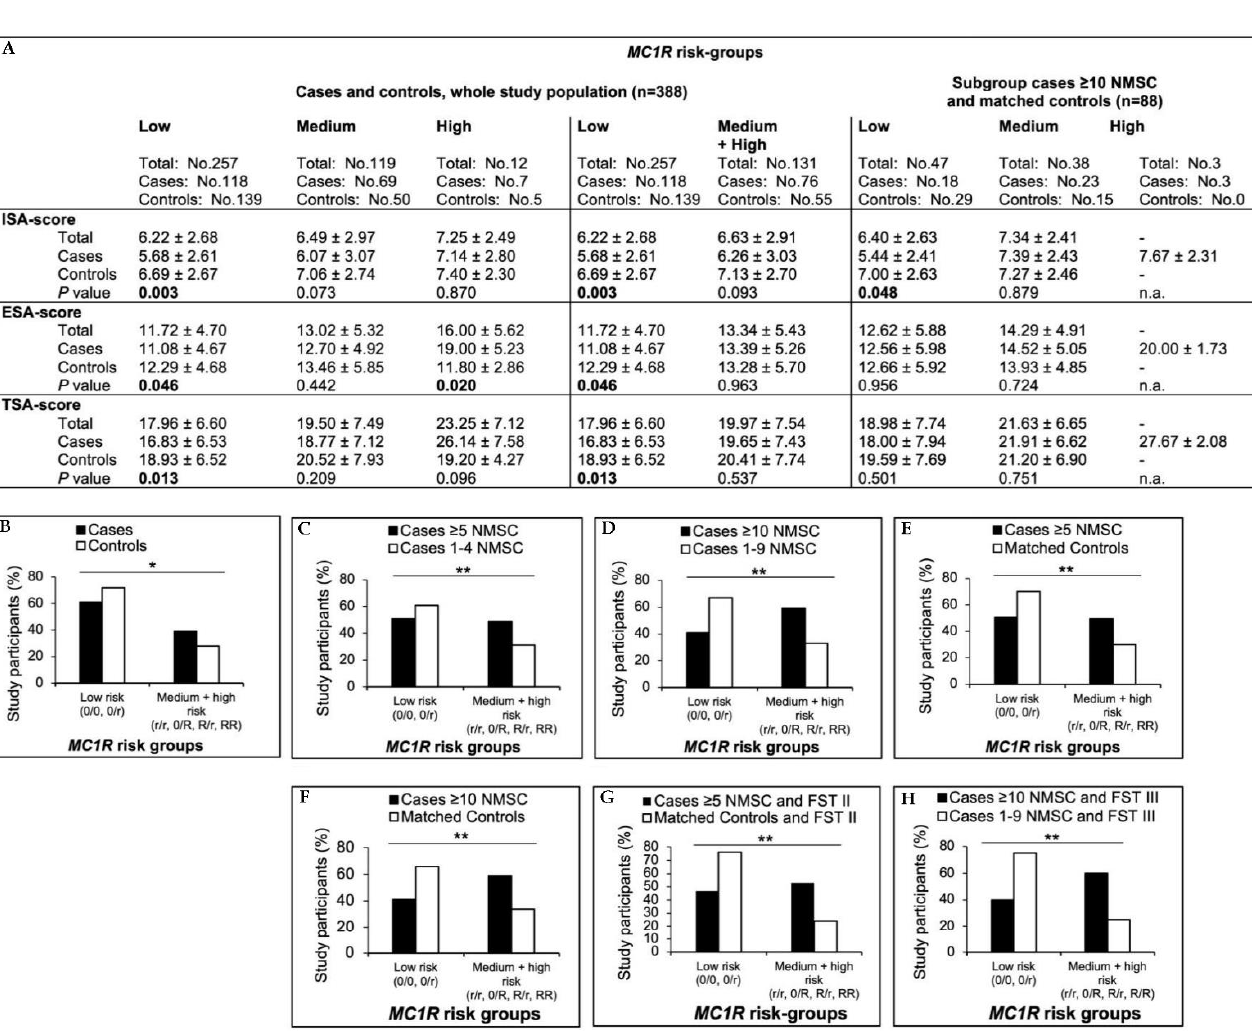
Figure 4. Distribution of MC1R risk groups in different cases/controls scenarios: ( A ) correlated with skin aging scores; significant p values ( p < 0.05) calculated by Chi-square test are displayed in bold; n.a.: not available, ISA: intrinsic skin aging, ESA: extrinsic skin aging, TSA: total skin aging; ( B ) in the entire study population, *: p = 0.03; ( C ) in cases with ≥ 5 NMSC ( n = 87) and cases with 1–4 NMSC ( n = 107), **: p = 0.004; ( D ) in cases with ≥ 10 NMSC ( n = 44) and cases with 1–9 NMSC ( n = 150), **: p = 0.01; ( E ) in cases with ≥ 5 NMSC ( n = 87) and matched controls ( n = 87), **: p = 0.008; ( F ) in cases with ≥ 10 NMSC ( n = 44) and matched controls ( n = 44), **: p = 0.019; ( G ) in cases with ≥ 5 NMSC and FST II ( n = 48) and matched controls and FST II ( n = 34), **: p = 0.008; ( H ) in cases with ≥ 10 NMSC and FSTIII ( n = 15) and cases with 1–9 NMSC and FSTIII ( n = 68), **: p = 0.008.